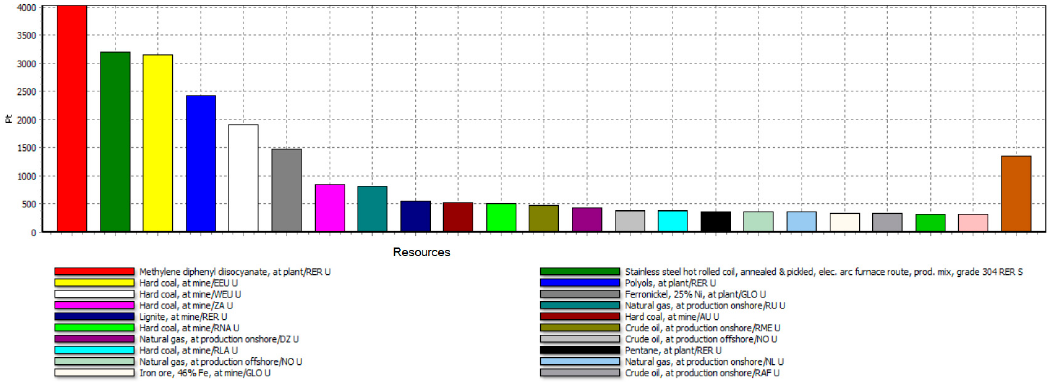
Figure 8. Comparison of major environmental impacts, related to the steel structure of the o ffi ce building, on the resources damage category.